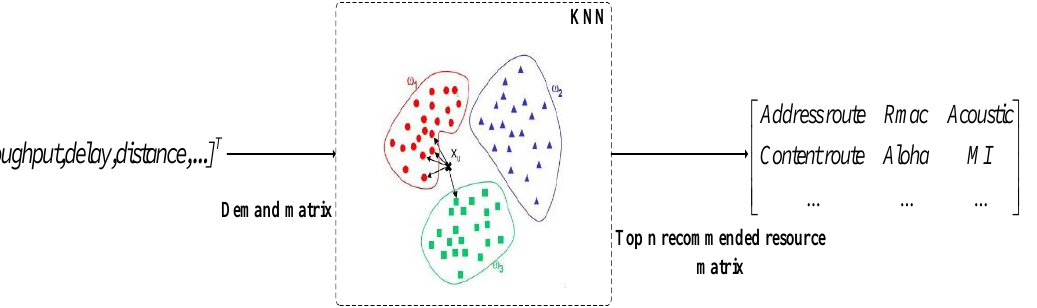
Figure 8. Recommend network configuration based on requirements.